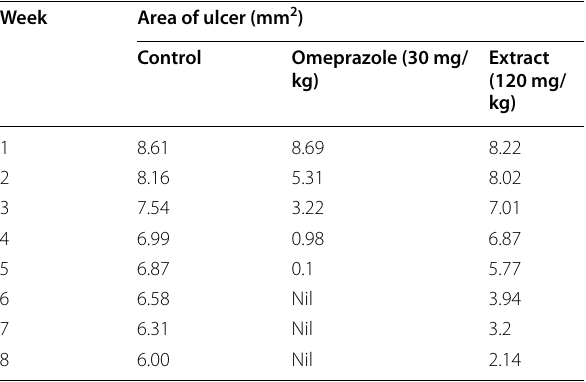
Table 4 Effect of omeprazole and C. zeylanica extract on area of ulcer in naproxen-induced therapeutic